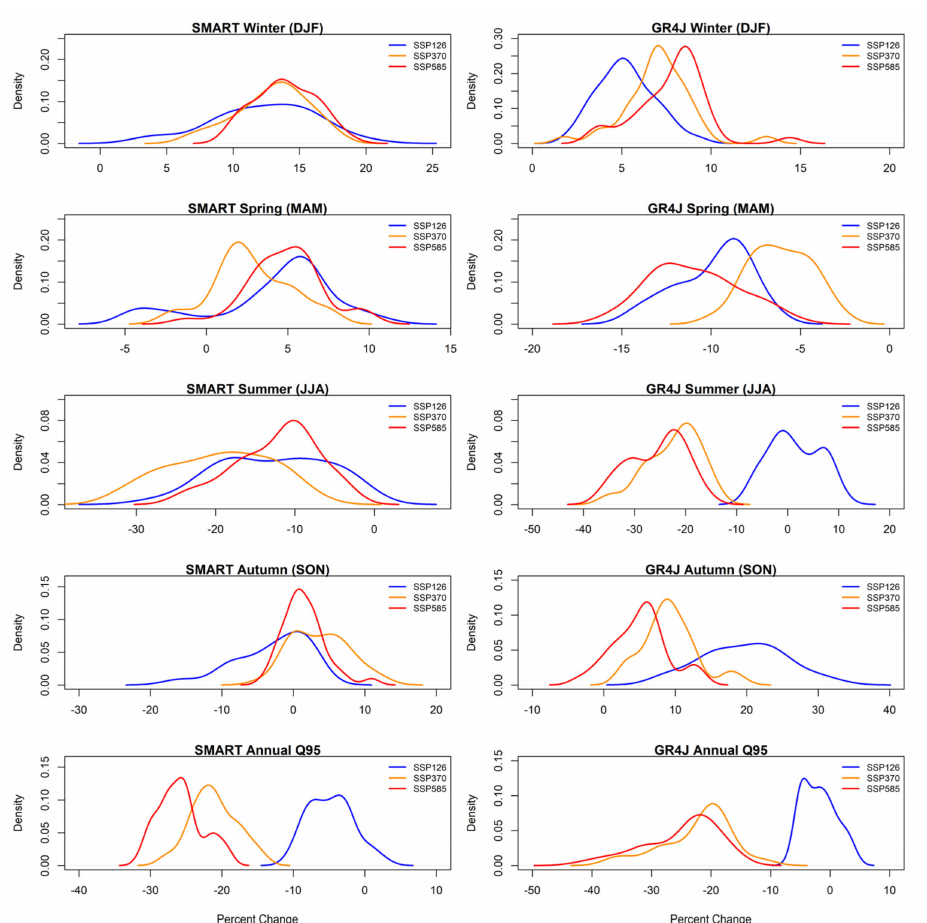
Figure 9. Density functions of median changes in the seasonal mean and annual low flows simulated by SMART ( left ) and GR4J ( right ) across all catchments for each SSP during the